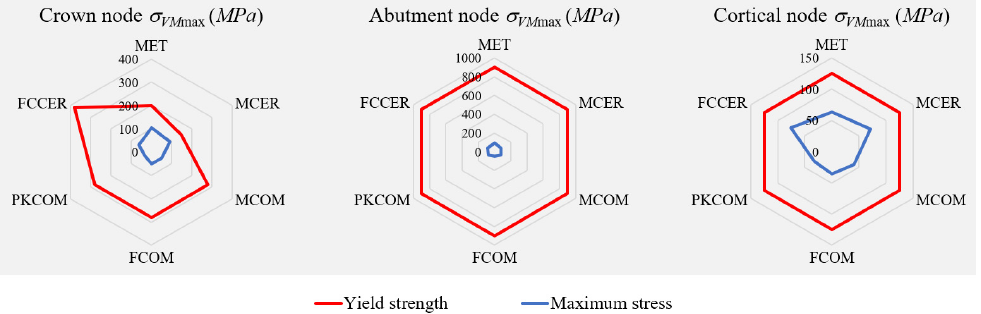
Figure 8. Spider plots comparing the yield strength of the materials and the maximum von Mises stress obtained for each node.